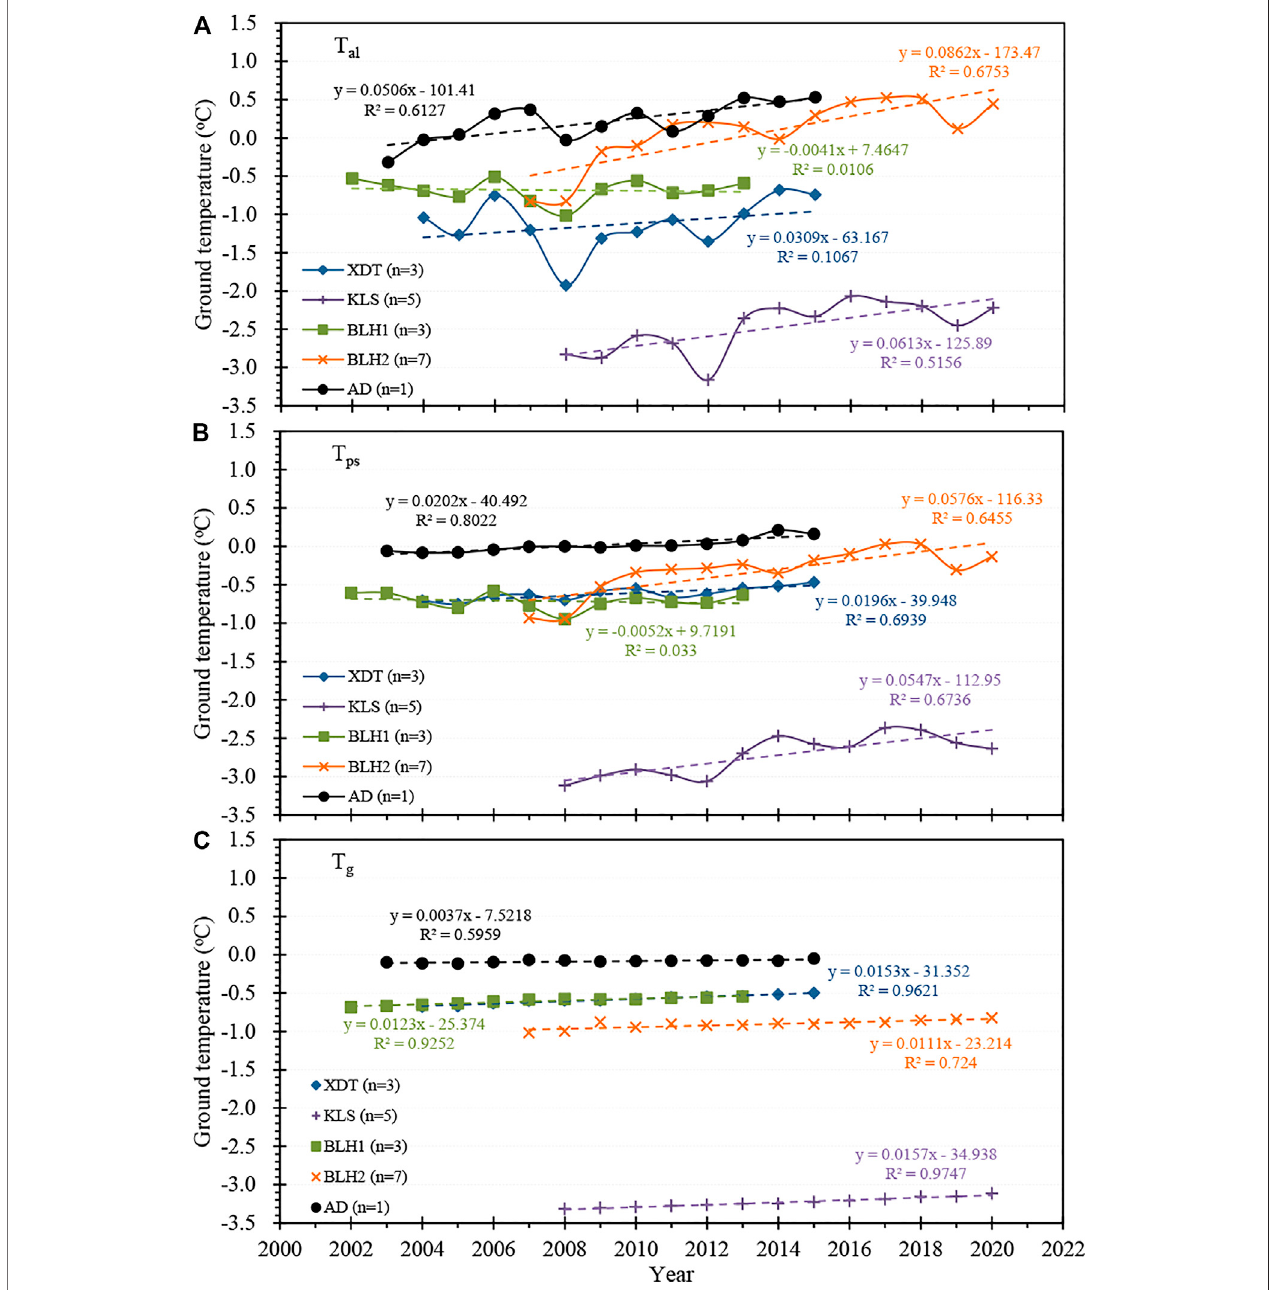
FIGURE7| RecentvariationsinannualmeanT al (A) ,T ps (B) ,andT g (C) atthe fi vesitesfornearly20 years.Thedataareanaveragevalueofseveralboreholes(n)at each site.